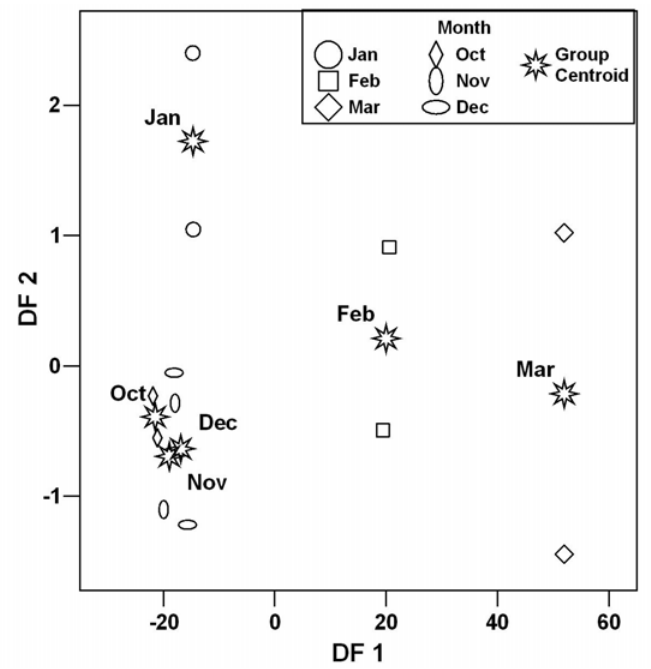
F IG . 2.- Discriminant Function Analysis of five characters from October to